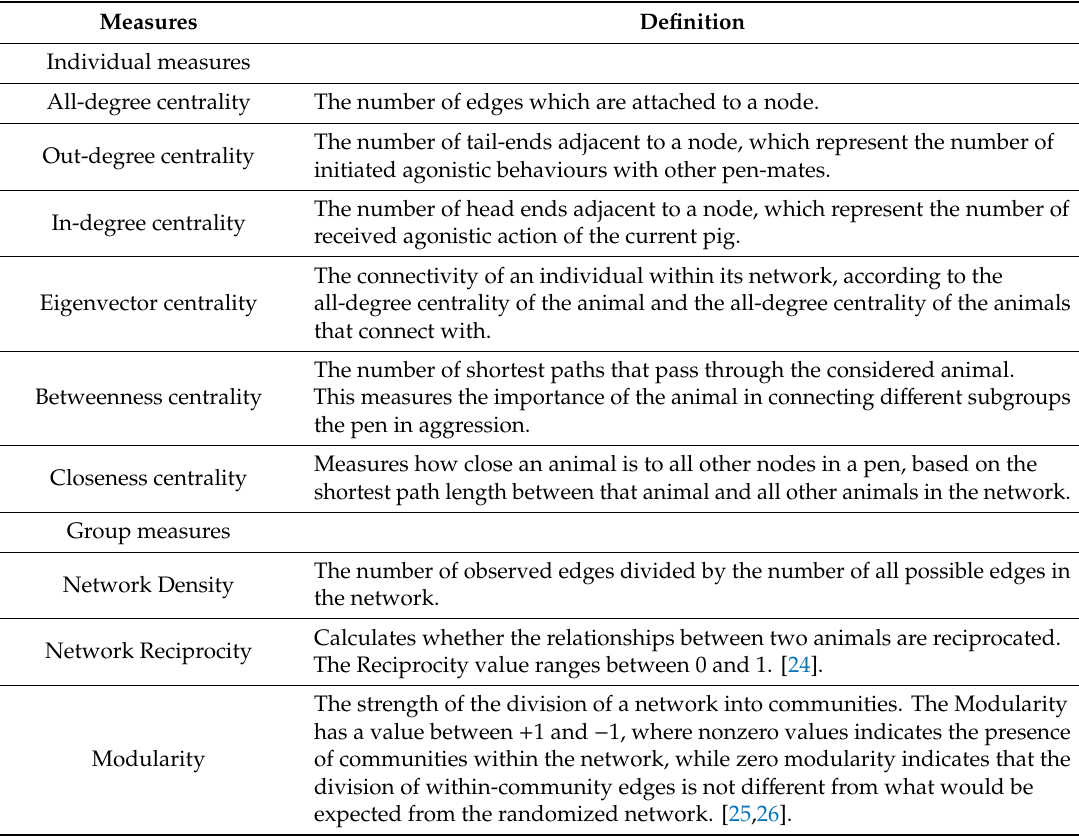
Table 2. The definition of each Social Network individual and group